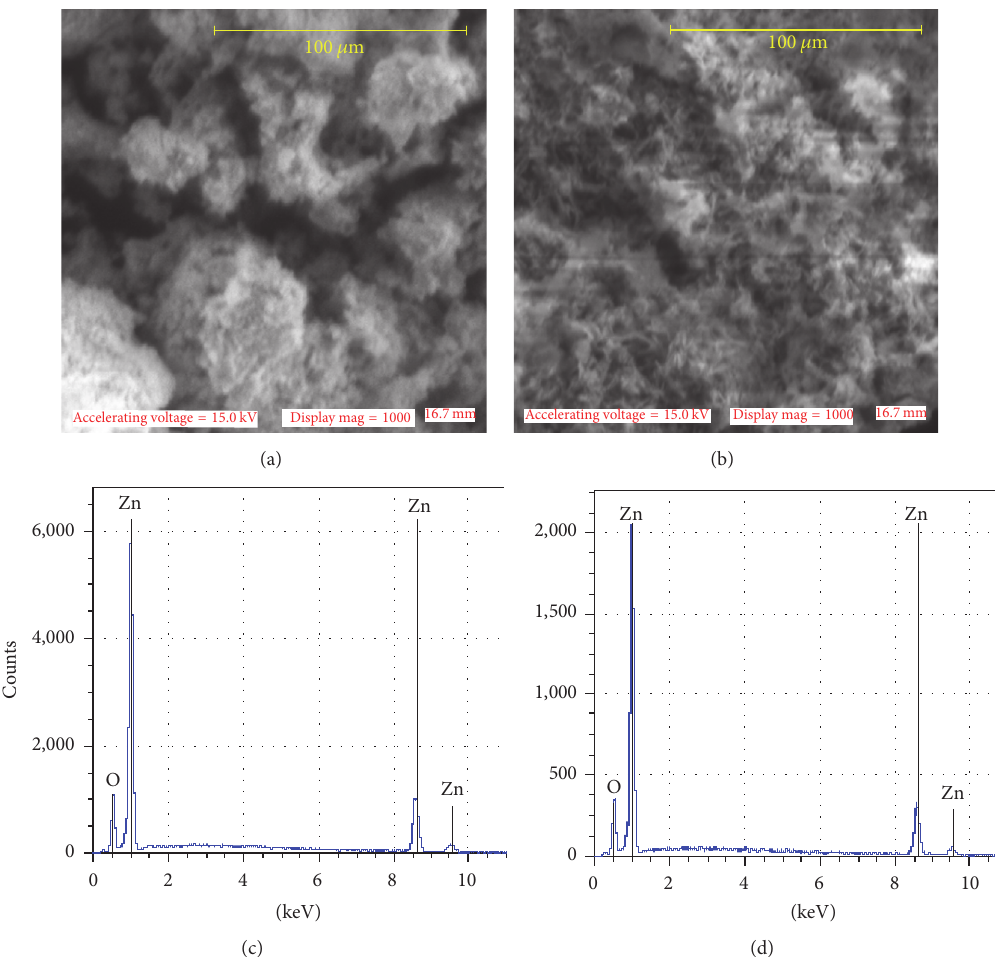
Figure 3: (a-b) SEM micrographs and (c-d) EDX spectra of 0.01% and 0.02% starch-mediated ZnO samples, respectively.